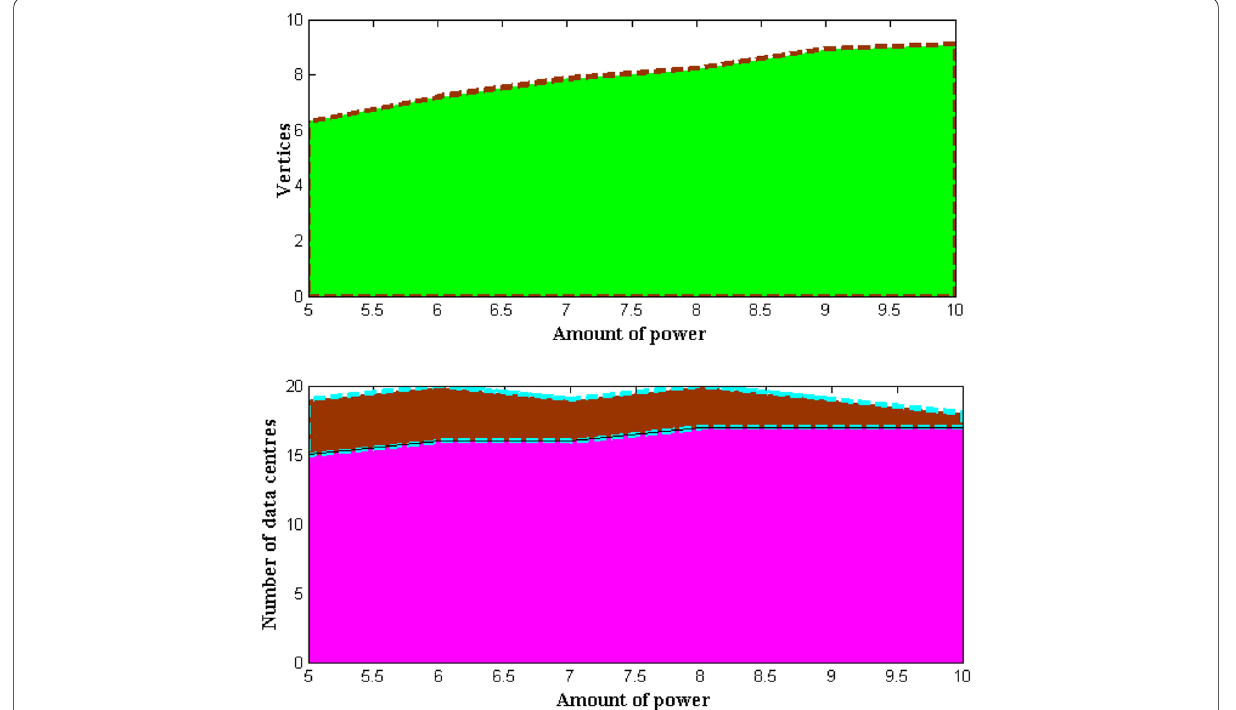
Fig. 5 Comparison of power with data